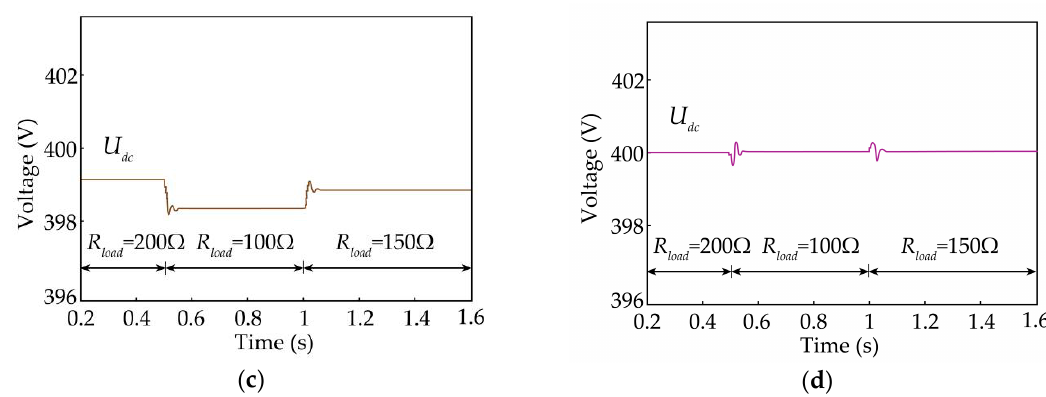
Figure 15. Simulation results of Case 2. ( a ) The current distribution under the traditional algorithm; ( b ) the current distribution under the proposed algorithm; ( c ) the bus voltage under the traditional algorithm; ( d ) the bus voltage under the proposed algorithm.